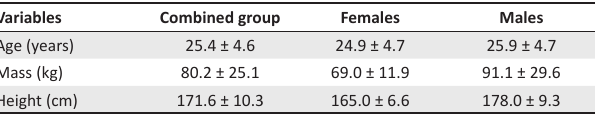
TABLE 1: Demographic and anthropometric information of the participants ( n = 16). Variables Combined